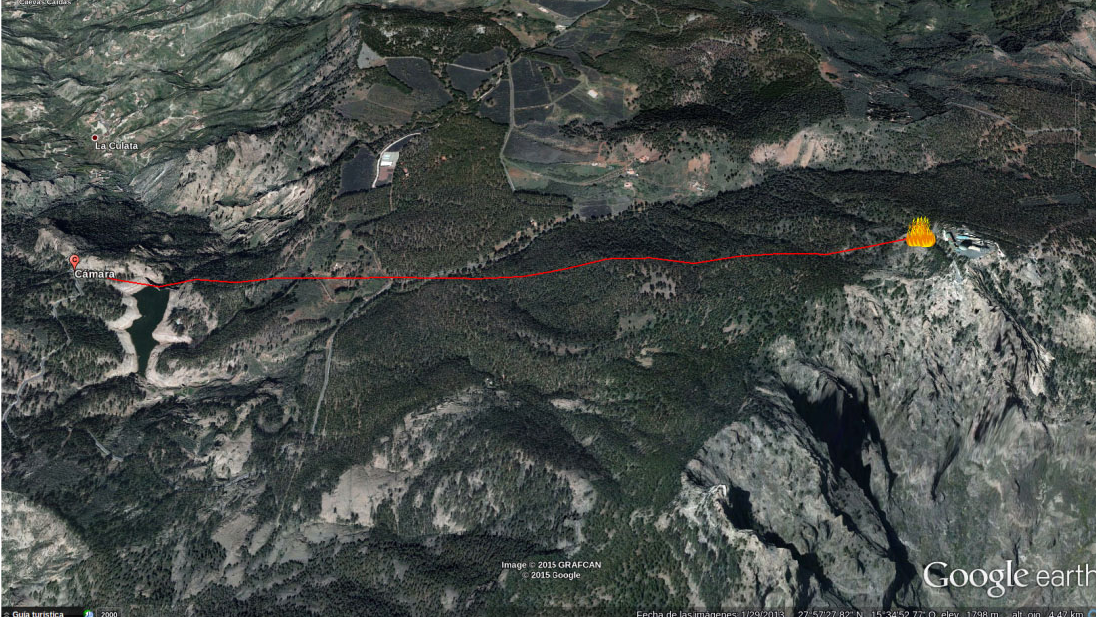
Figure 13. Automated geolocation of the wildfire seen with Google